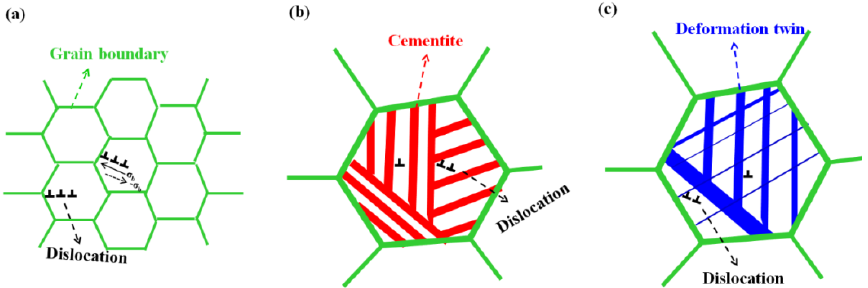
Figure 9. Schematic comparison of the main strengthening mechanism of ( a ) ferritic, ( b ) pearlitic, and ( c ) TWIP steels during plastic forming.